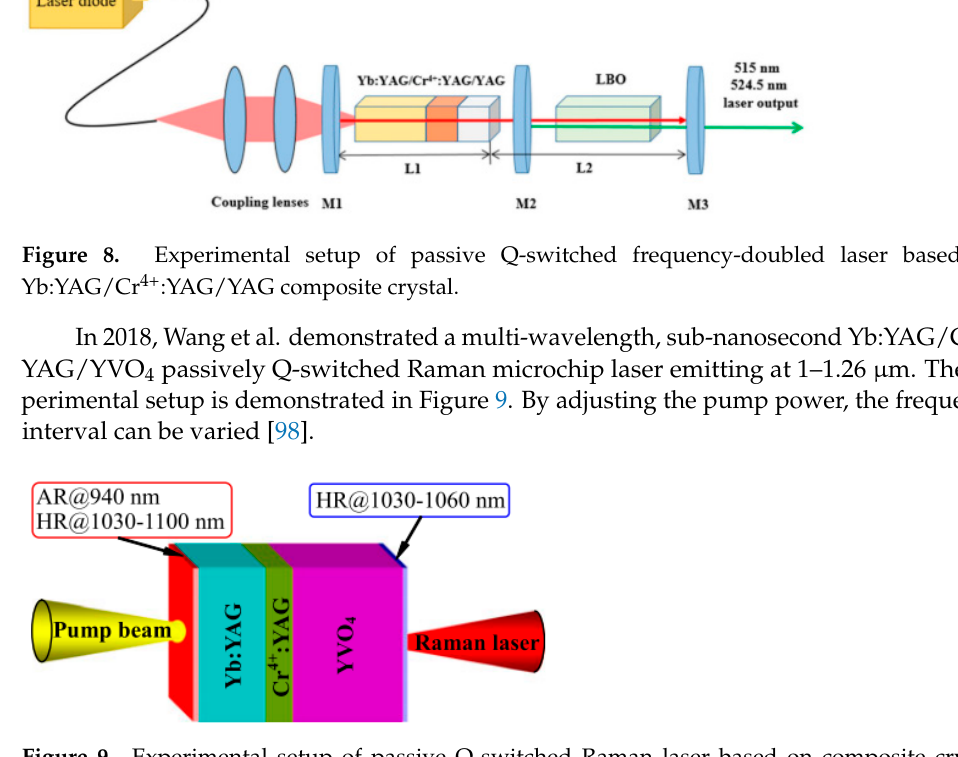
Figure 9. Experimental setup of passive Q-switched Raman laser based on composite crystal Yb:YAG/Cr 4+ :YAG/YVO 4 .